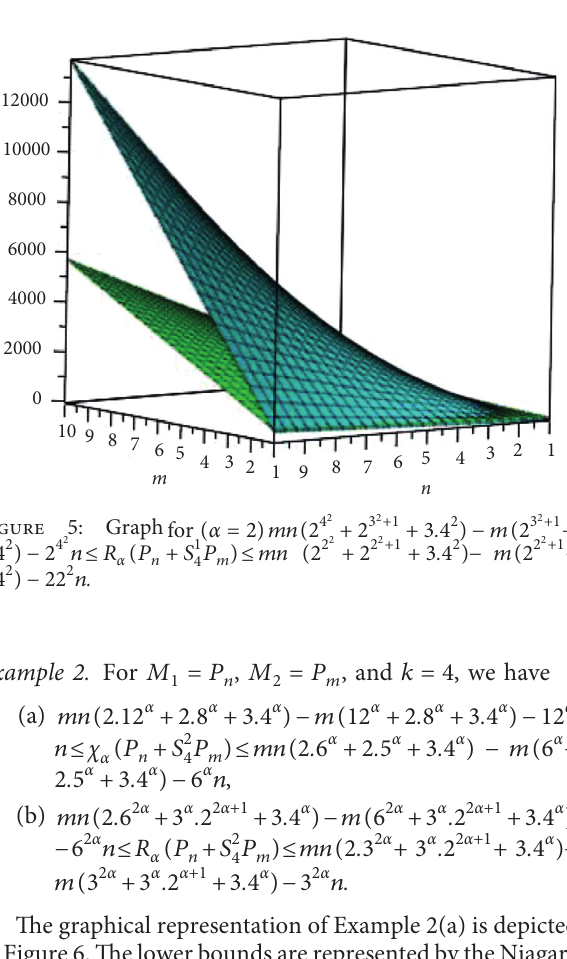
The graphical representation of Example 3(a) is depicted in Figure 8. The lower bounds are represented by the blue graph and the upper bounds are represented by the green graph. The graphical representation of Example 3(b) is depicted in Figure 9. The lower bounds are represented by the yellow graph and the upper bounds are represented by the gray graph.